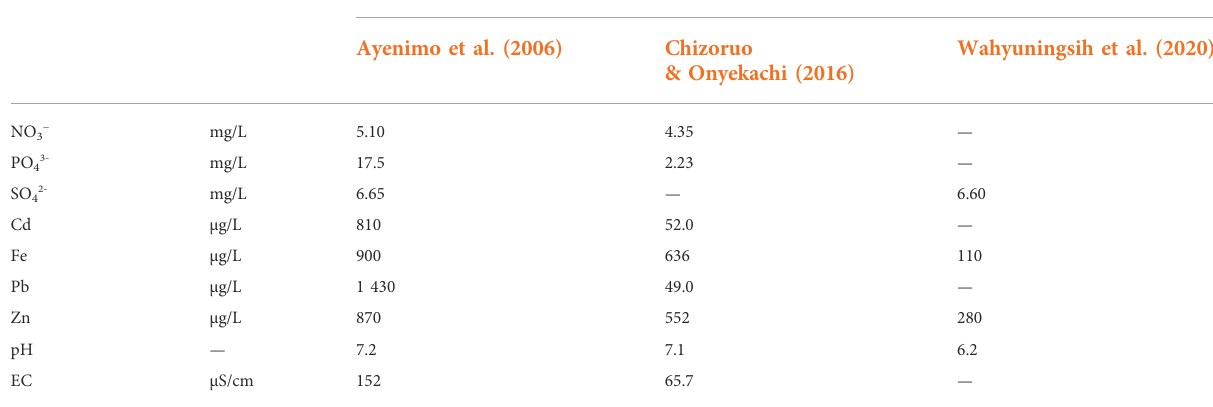
TABLE 5 Mean values of different parameters in asbestos concrete roof